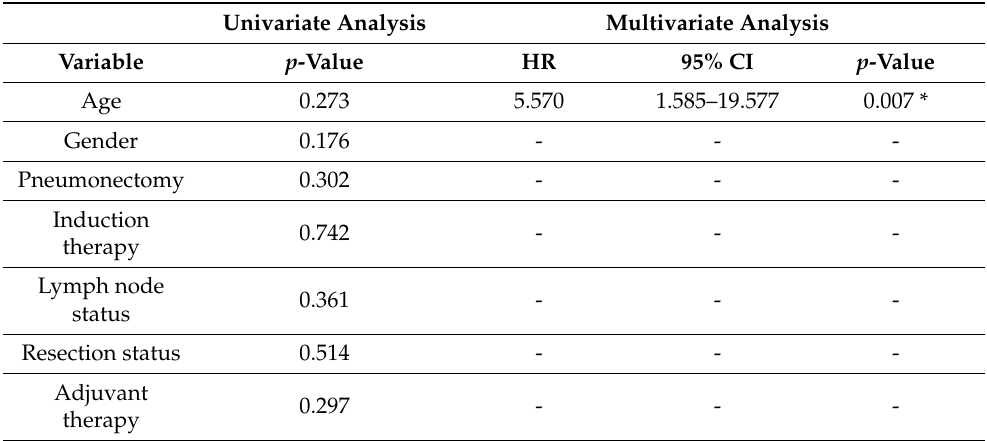
Table 4. Univariate and multivariate analyses with overall survival in months as the dependent